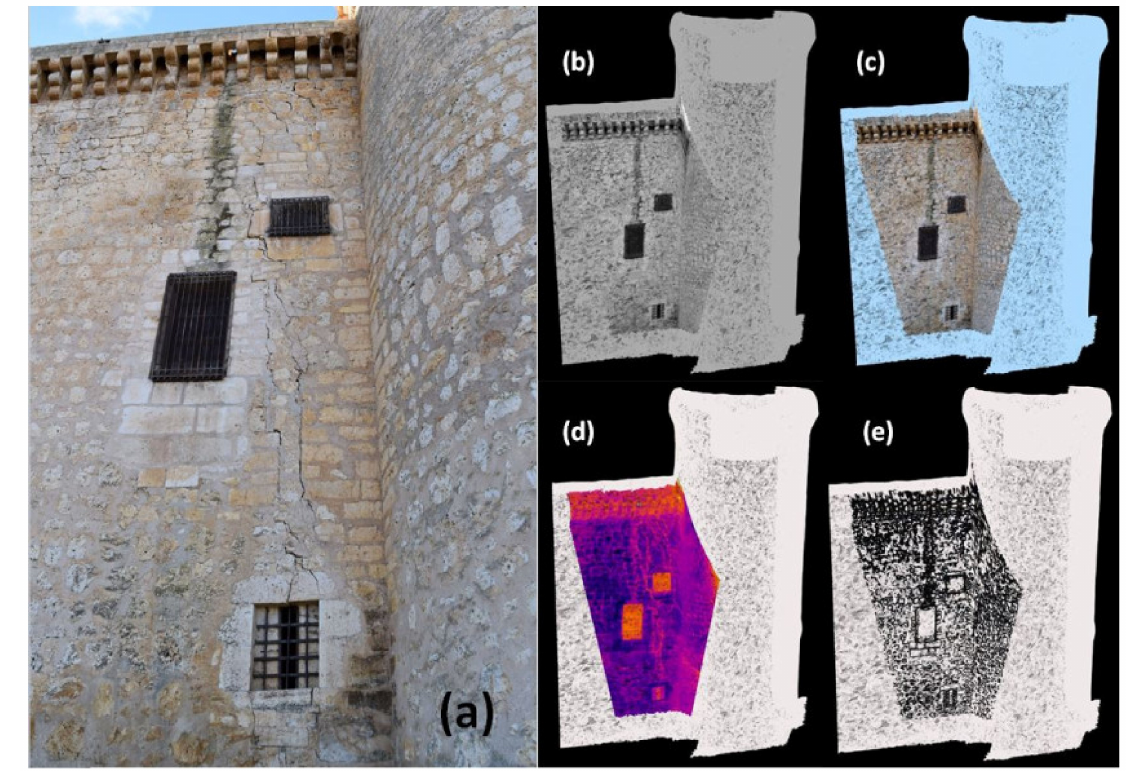
Figure 3. ( a ) NE wall of the Castle of Torrelobat ó n; ( b ) reflectance info; ( c ) color info; ( d ) thermal info; ( e ) multispectral info.